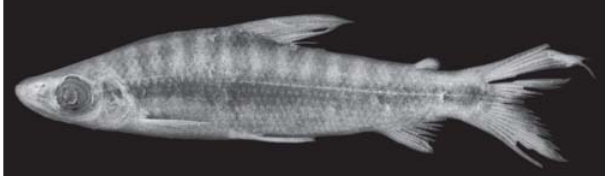
Fig. 7. Young specimen of Laemolyta fernandezi , MZUSP 20842, 63.6 mm SL; Brazil, Mato Grosso, rio Araguaia, Santa Terezinha.